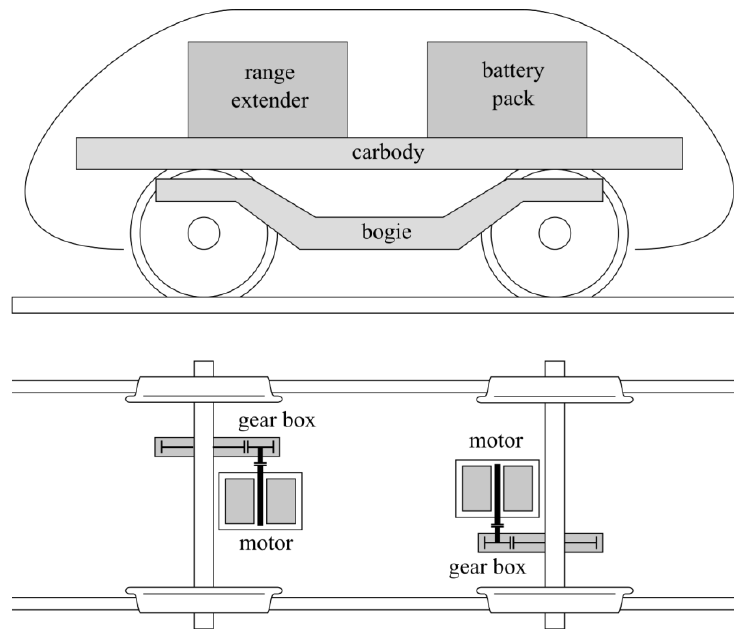
Figure 1. Design of the driverless railway vehicle.